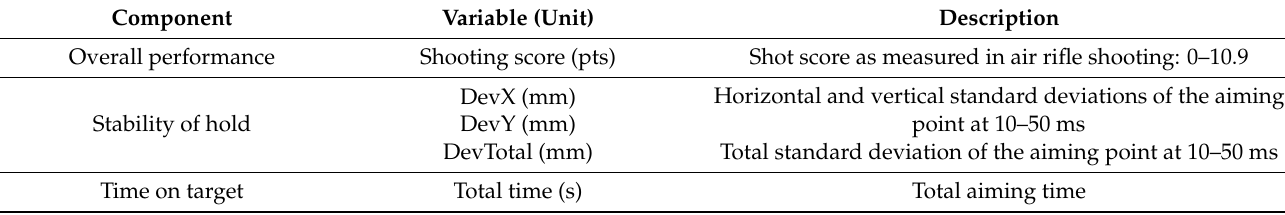
Table 1. Variables calculated from the aiming point trajectory.